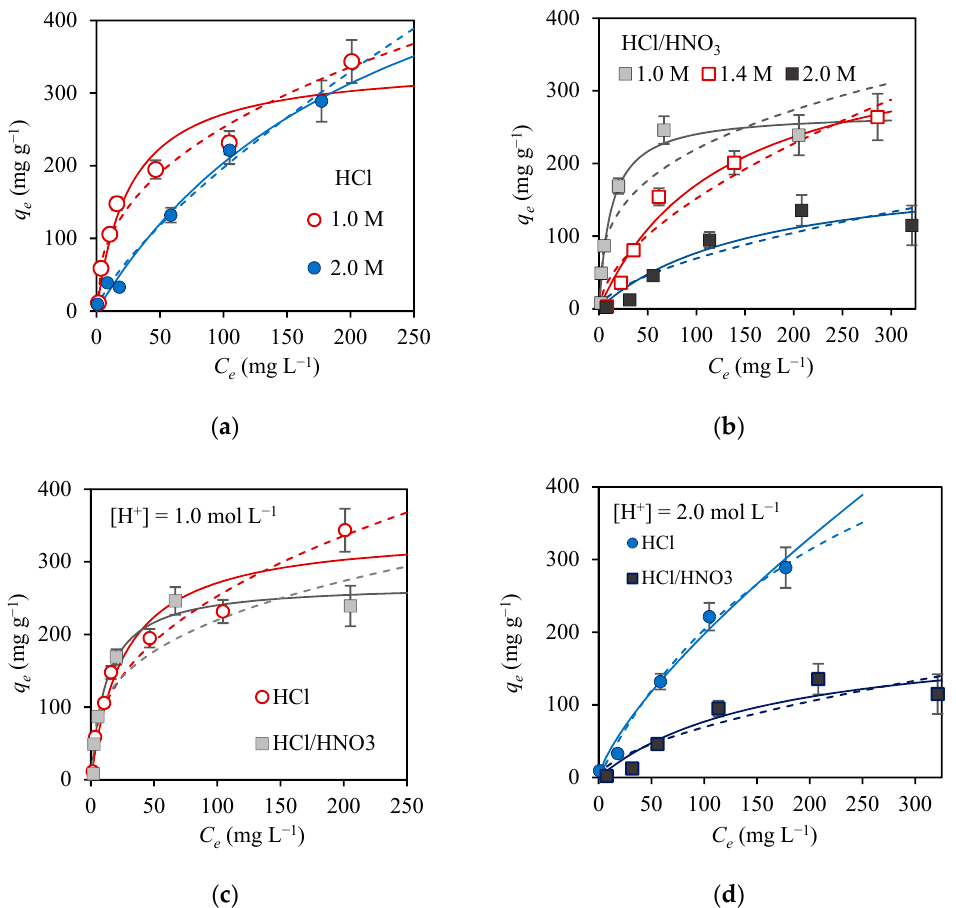
Figure 2. Equilibrium isotherms for the adsorption of gold by the pine bark tannin resin from different acidic matrices (20 °C, S/L = 1.0 g L − 1 ): effect of H + concentration in ( a ) HCl and ( b ) aqua regia solutions; effect of the leaching solution for a total H + concentration of ( c ) 1.0 and ( d ) 2.0 mol L − 1 . C e denotes the gold concentration in the liquid phase, in equilibrium with the metal adsorbed amount, q e . Langmuir and Freundlich models are represented by solid and dashed lines,